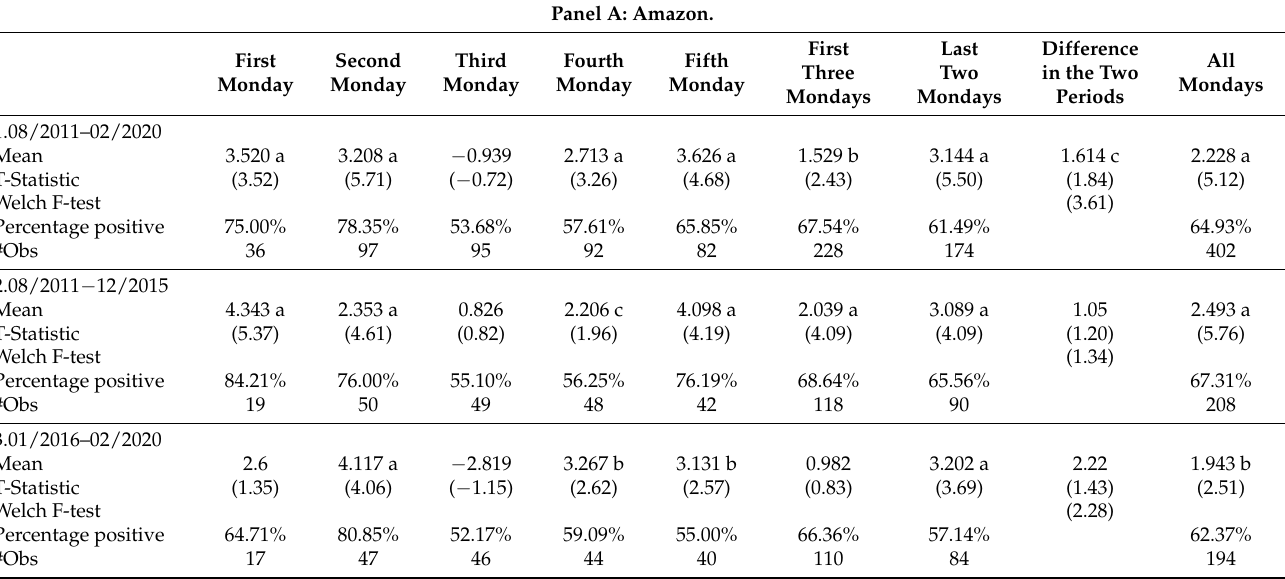
Table 5. Summary statistics for the Monday return categorized by week. Panel A: